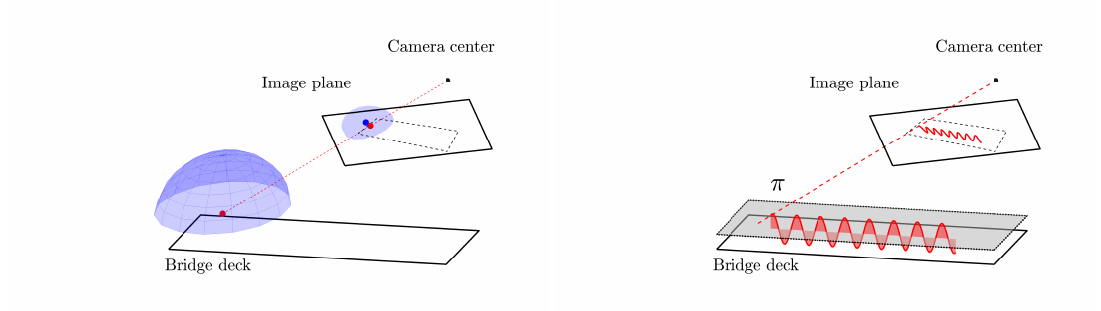
Figure 23. Conceptual illustration of the systematically induced measurement errors: ( left ) the colored hat (blue hemisphere) is not projection invariant when projected onto the image plane (blue ellipsoid) and its centroid (blue dot) does not coincide with the projected center of mass of the sphere (red dot). ( right ) In case of mono-view, the vertical sway of the pedestrian’s head around the plane π induces an error as it does not coincide with the plane π